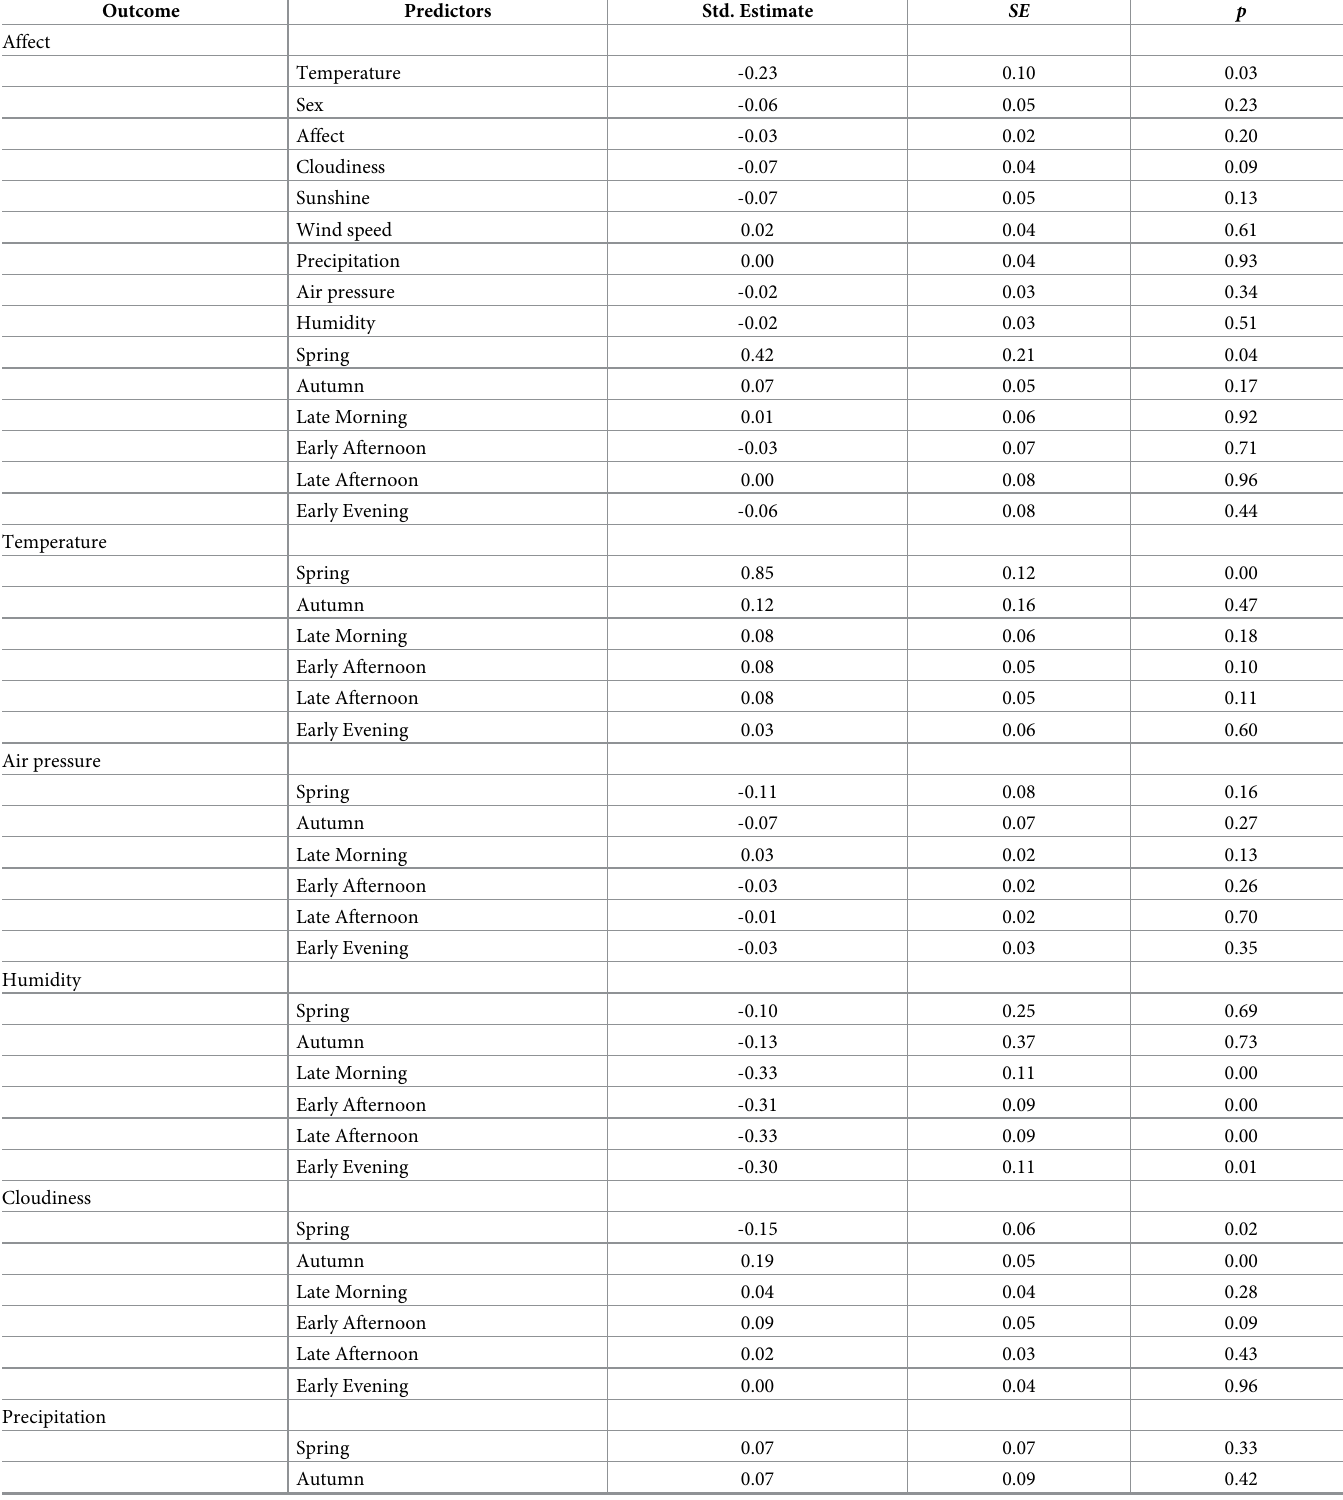
Table 3. Path analysis